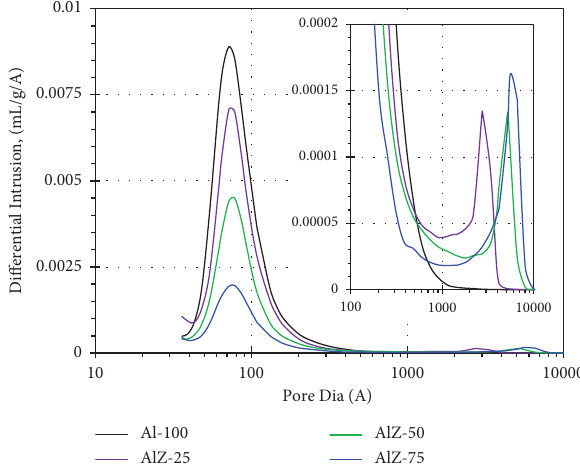
Figure 4: Hg intrusion-extrusion pressure and isotherms.